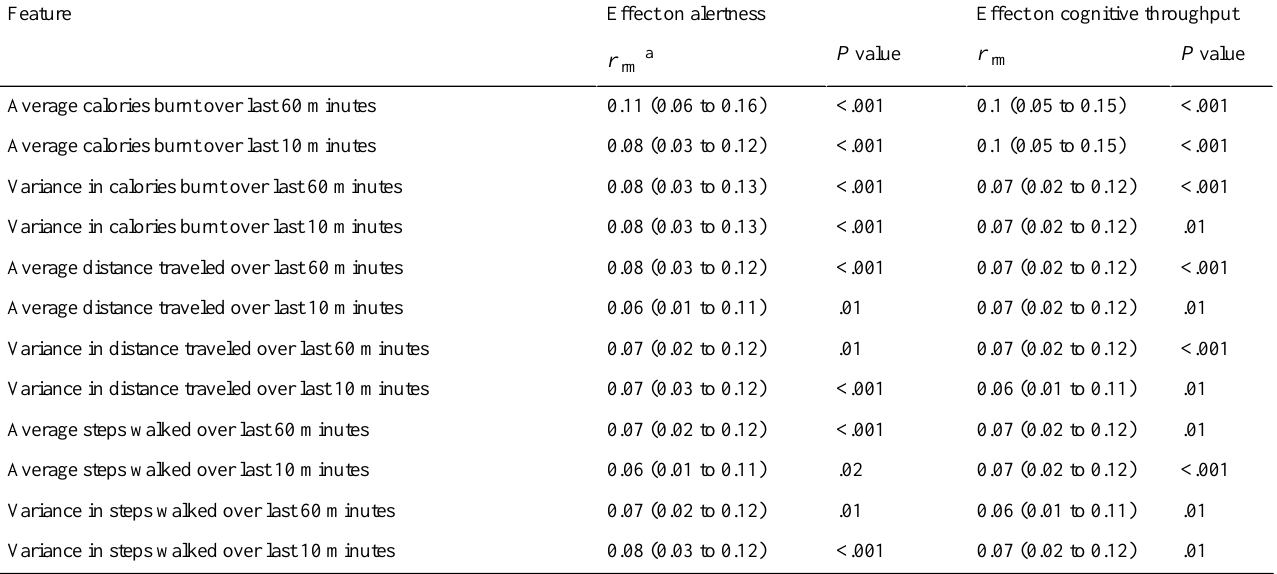
Table 10. Effect of physical activity on momentary alertness and cognitive throughput.